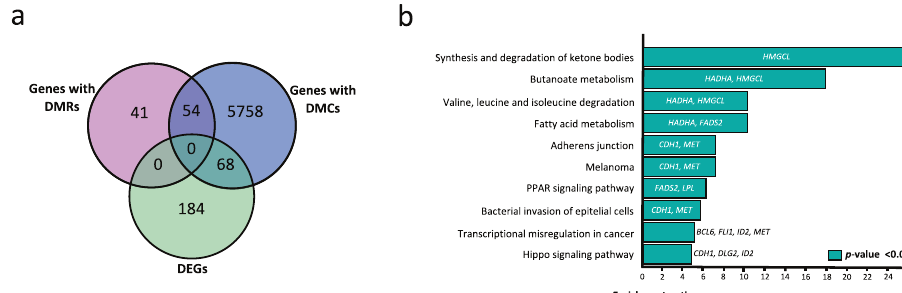
Fig. 2 Overlap of differential methylation and gene expression. a Venn diagram showing overlap between genes with DMCs or DMRs and the DEGs. b Gene set enrichment analysis of overlapping DMC-DEG genes. Kyoto Encyclopedia of Genes and Genomes pathway enrichments associated with genes with DMCs. X axis: p value. DMCs differentially methylated CpGs, DMRs differentially methylated regions, DEGs differentially expressed